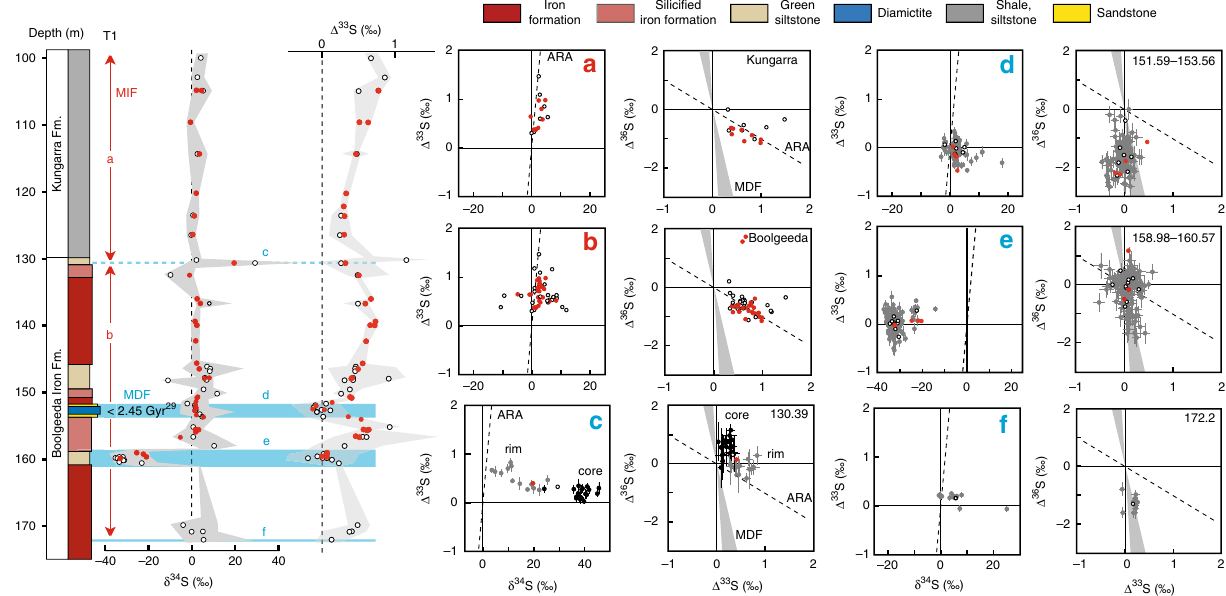
Fig. 3 δ 34 S and Δ 33 S pro fi les of sulphides in drill core T1 and associated δ 34 S- Δ 33 S and Δ 33 S- Δ 36 S compositional diagrams. a , b Samples of the Boolgeeda and Kungarra Formations characterized by a limited range of δ 34 S values, small 33 S-anomalies and plotting on the Archaean reference array (ARA) with a slope of approximately − 1 in a Δ 33 S- Δ 36 S diagram. c – f Sedimentary intervals (151.59 – 153.56 and 158.98 – 160.57) or individual samples (130.39 and 172.2) showing variable δ 34 S values, near-zero Δ 33 S values and plotting on the MDF Δ 33 S- Δ 36 S array of slope approximately − 7 (light blue areas labelled c – f on the δ 34 S and Δ 33 S pro fi les). Red dots, bulk analysis; white dots, mean value of in situ analysis for each sample; grey dots, individual spot analysis using the SHRIMP-SI (error bars are standard deviation of 1 σ , see Methods). Black and grey dots in c correspond to core and rim S-isotope composition, respectively (see text). The grey shaded areas in the δ 34 S and Δ 33 S pro fi les represent the range of individual spot analysis for each sample. The stratigraphic column below 130 m depth (Boolgeeda IF) corresponds to the domain (i) discussed in the text and shown in Fig.